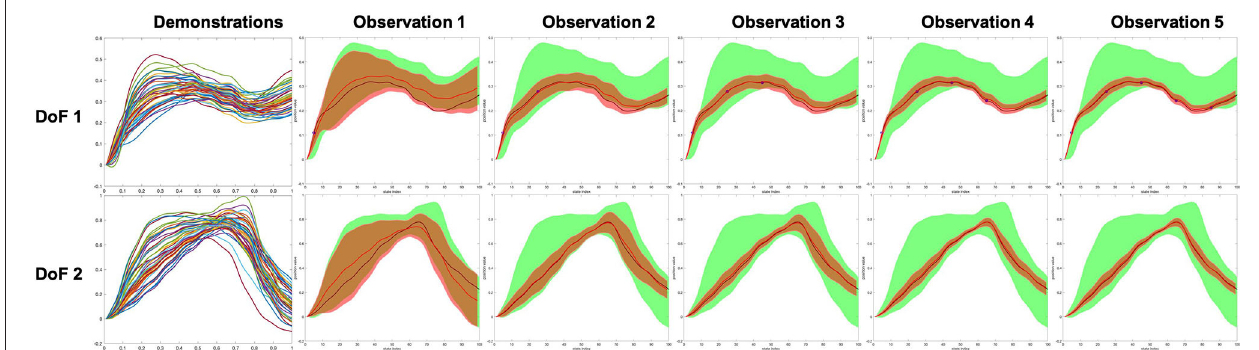
FIGURE 5 | A two degree of freedoms (DoFs) example showing how the model being modulated while maintaining the coupling between DoFs. The shade indicates the 2- σ confidence of the value. The green and red shades are representing the prior and modulated inference, respectively. The red curve and black curve are the mean of the inference and the demonstrated ground truth, respectively. Five points of the DoF 1 were observed, and the algorithm updates (modulates) both DoF 1 and DoF 2